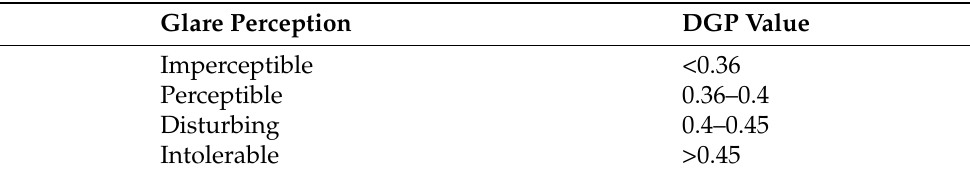
Table 1. Significance of DGP